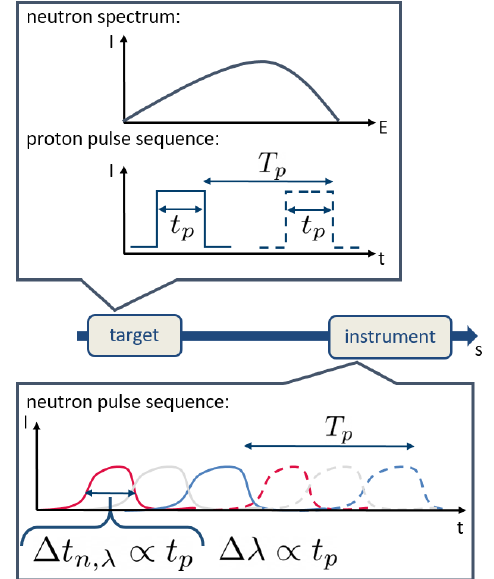
Figure 1. Schematic representation of the interplay of incoming proton beam pulse sequence with variable pulse length t p and frame length T p on the target with the observed neutron pulse sequence at the instrument. The colors in the lower plot indicate neutrons with short, intermediate and long wavelengths as red, gray and blue respectively. For simplicity the neutron pulses with di ff erent wavelength were drawn separately, note however that a real neutron pulse consists of continuously distributed energies, as indicated by the neutron spectrum in the top graph. The time interval within which neutrons of the same energy arrive at the instruments ∆ t n ,λ and the absolute wavelength uncertainty ∆ λ of neutrons at the instruments scales with the proton beam pulse length t p